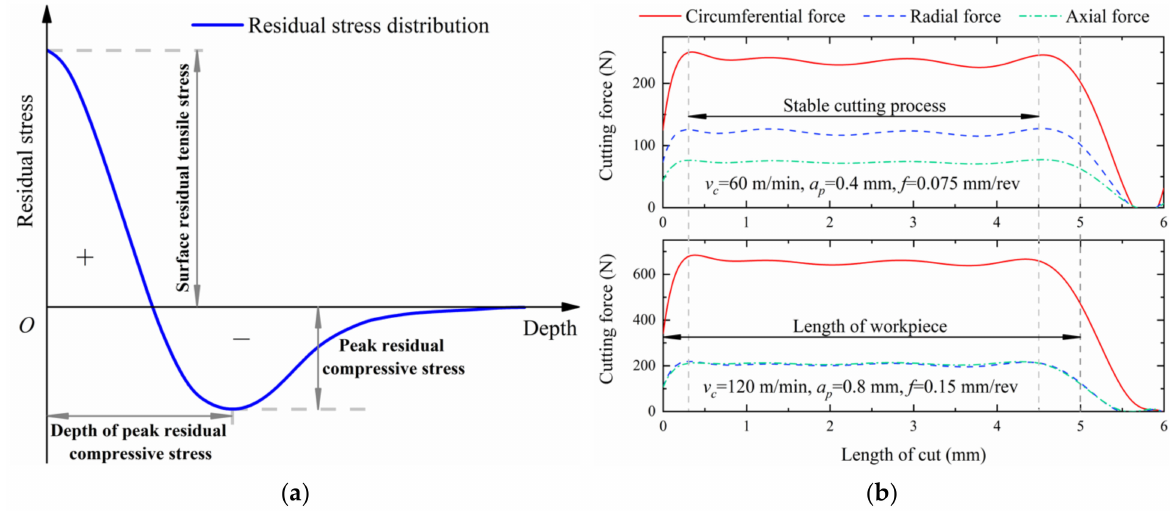
Figure 3. ( a ) The hook-shaped tendency of residual stress in the shallow surface [26]. ( b ) The cutting forces in the turning simulations.